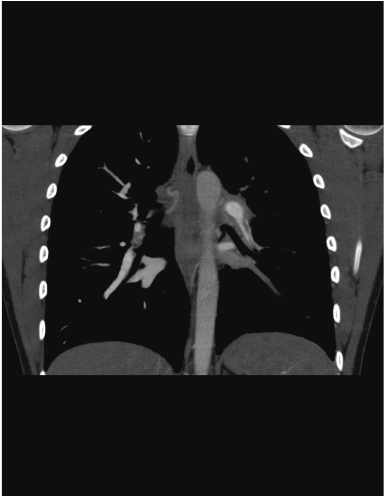
Figure 1: Coronal CT Image Demonstrating Pulmonary Arterial Thromboembolic Disease.